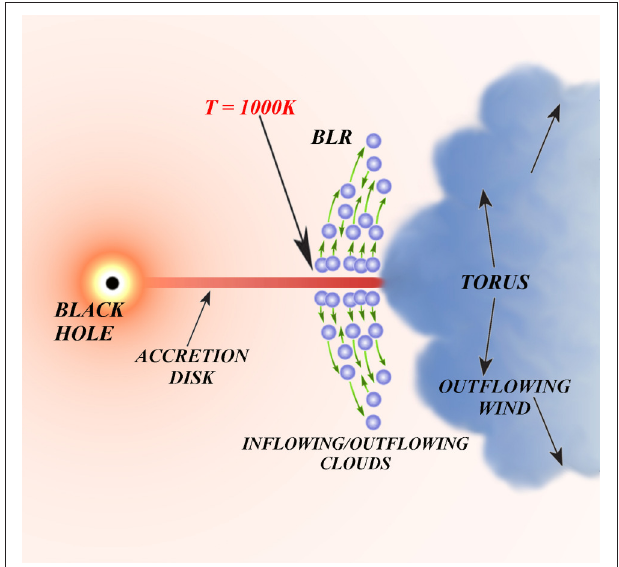
FIGURE 1 | Concept of the FRADO model for the